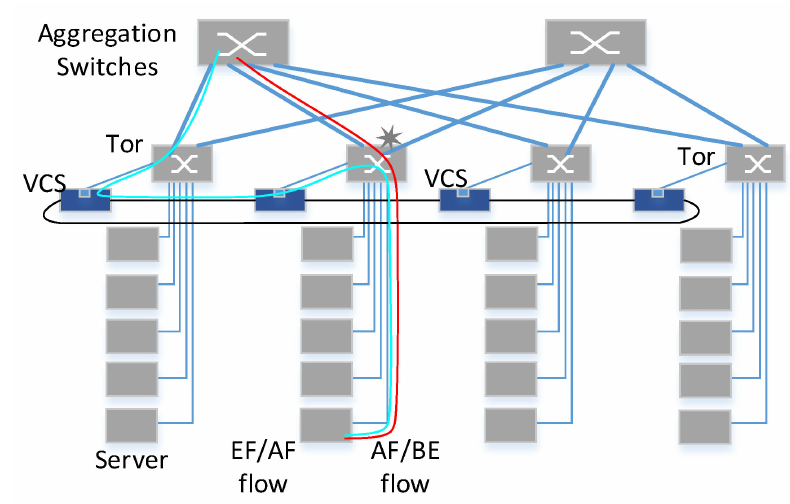
Figure 4. Data center network with virtual circuit